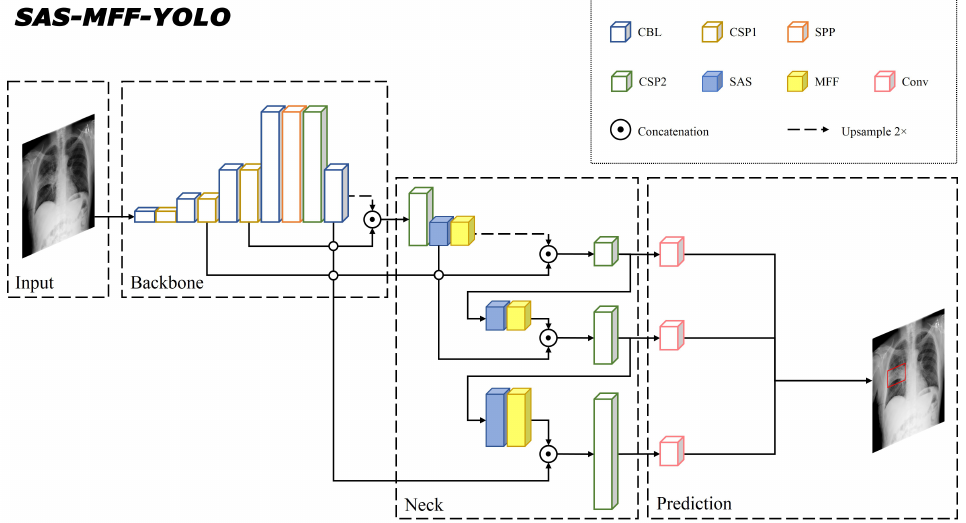
Figure 3. The overall structure of the embedded model SAS-MFF-YOLO. The blue blocks and yellow blocks represent the proposed SAS and MFF modules, respectively.